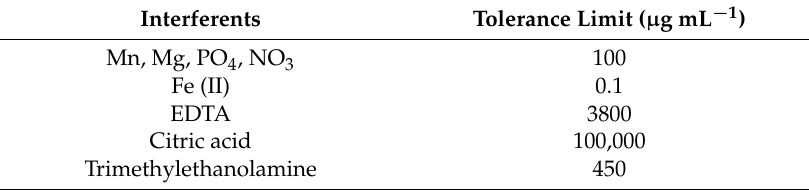
Table 2. Effect of foreign species on the determination of arsenic (III) (1 µ g mL − 1 ).